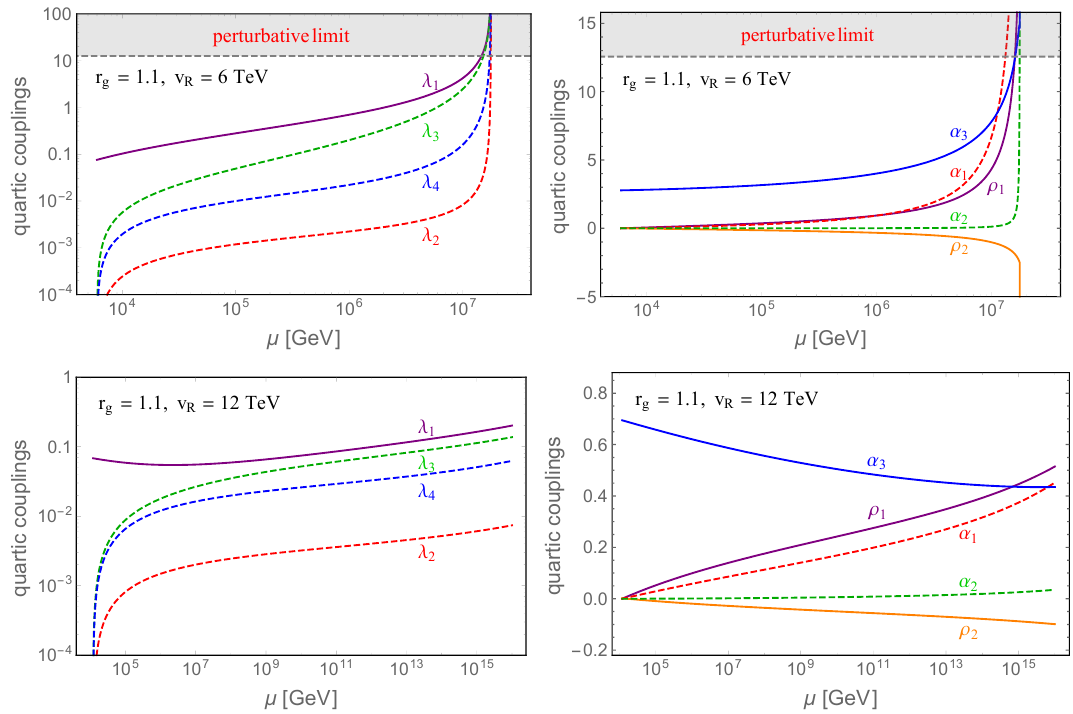
Figure 9 . RG running of the quartic couplings (cid:21) 1 ; 2 ; 3 ; 4 (left), and (cid:26) 1 ; 2 , (cid:11) 1 ; 2 ; 3 (right) in the scalar potential eq. (4.5) of minimal LRSM from v R up to the GUT scale, with r g = 1 : 1 and v R = 6 TeV (upper panels), v R = 12 TeV (lower